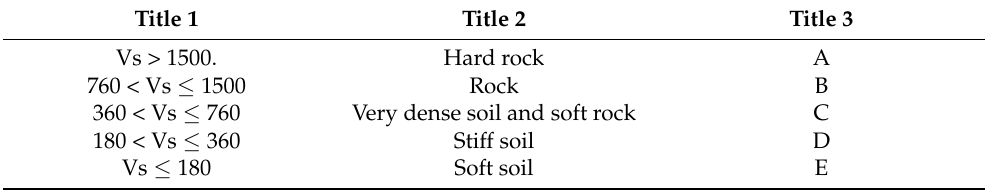
Table 2. NEHRP soil classification as a function of the average shear-wave velocity to 30 m depth